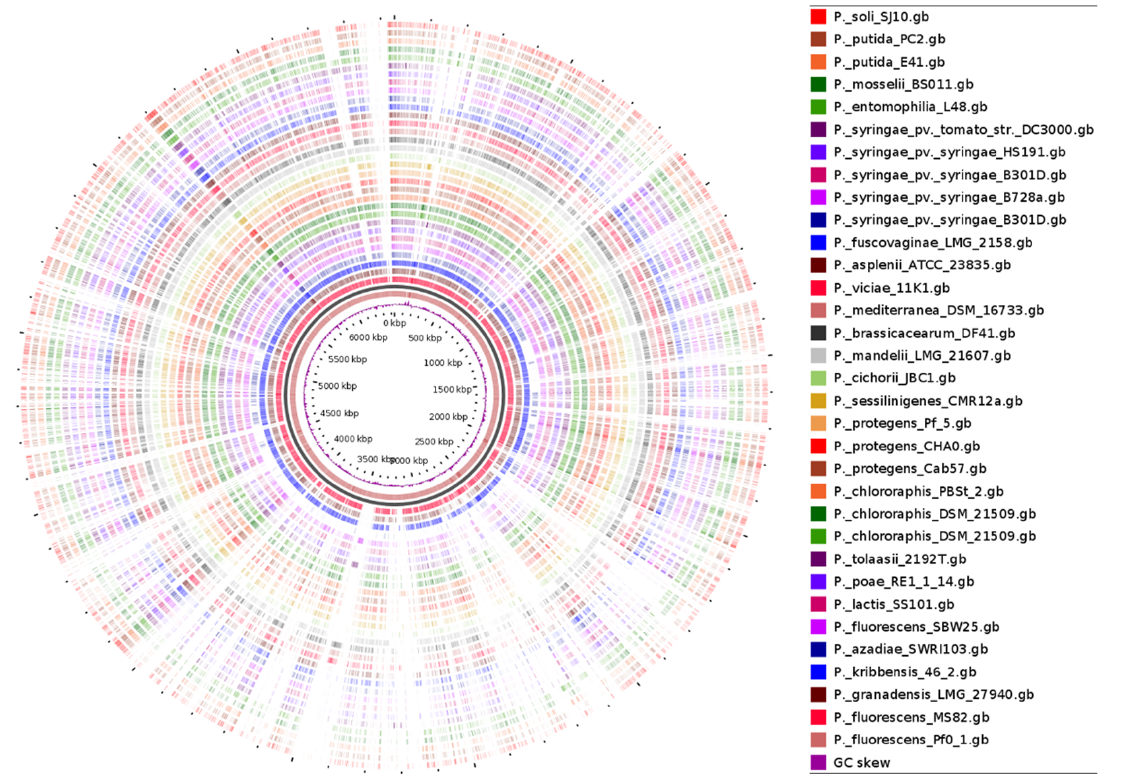
Figure 3. Comparative Genome Blast Atlas of 35 Lipopeptide-Producing Pseudomonas Strains. The BLAST Atlas analysis displays regions of the uploaded query files (34 genomes) where there are BLAST hits to the reference genome P. fluorescens Pf0-1). The GView Server was used [33].